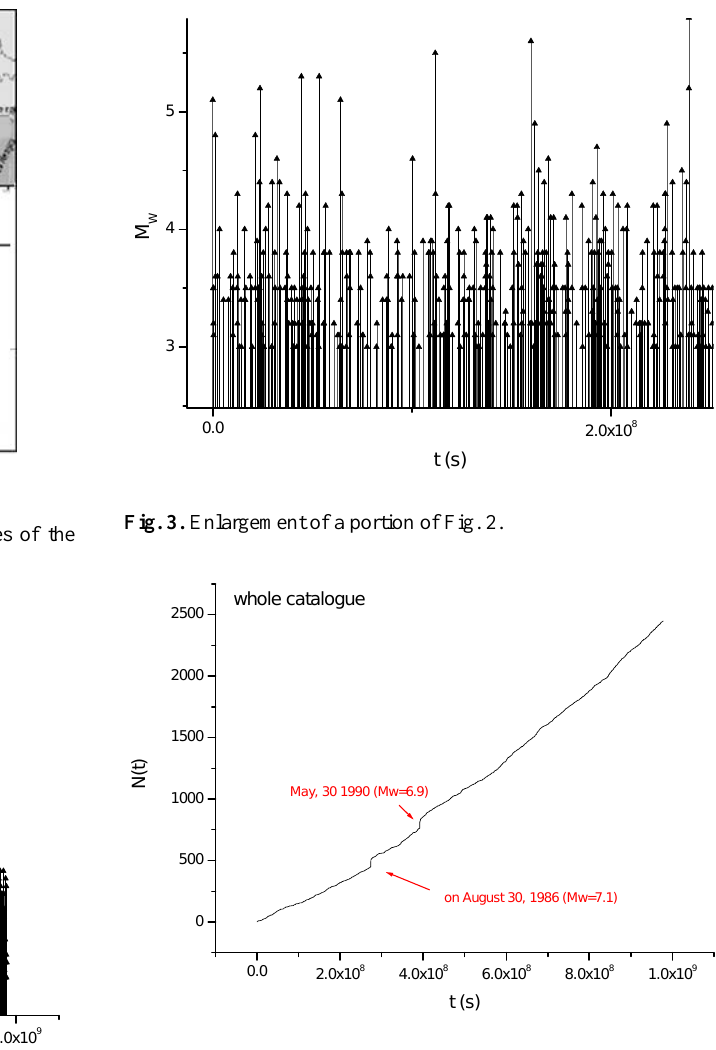
Fig. 4 Fig. 4. Cumulative number of earthquakes versus time of occur- rence for the full